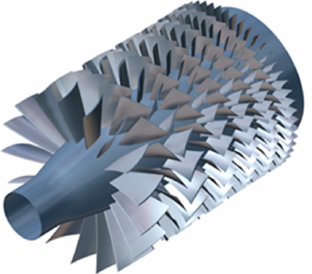
Figure 1. Overall configuration of the compressor.